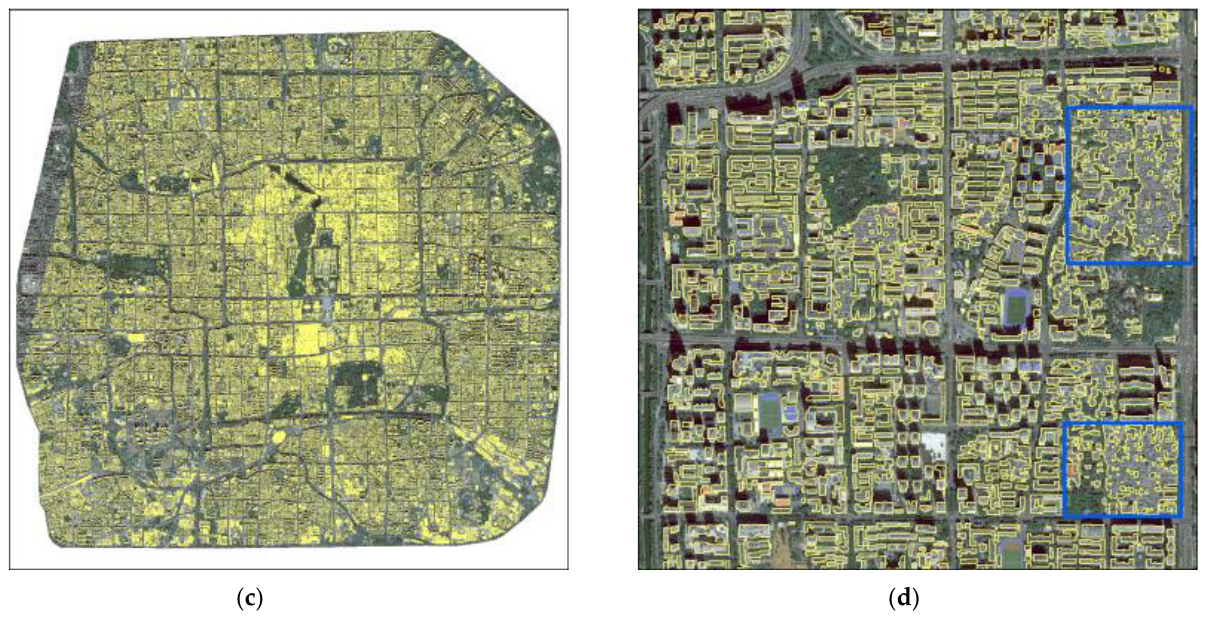
Figure 8. Extraction results of buildings in the study area. ( a ) the study area, ( b ) a typical local re- gion, ( c ) building extraction result using DMU-Net, ( d ) local region result.